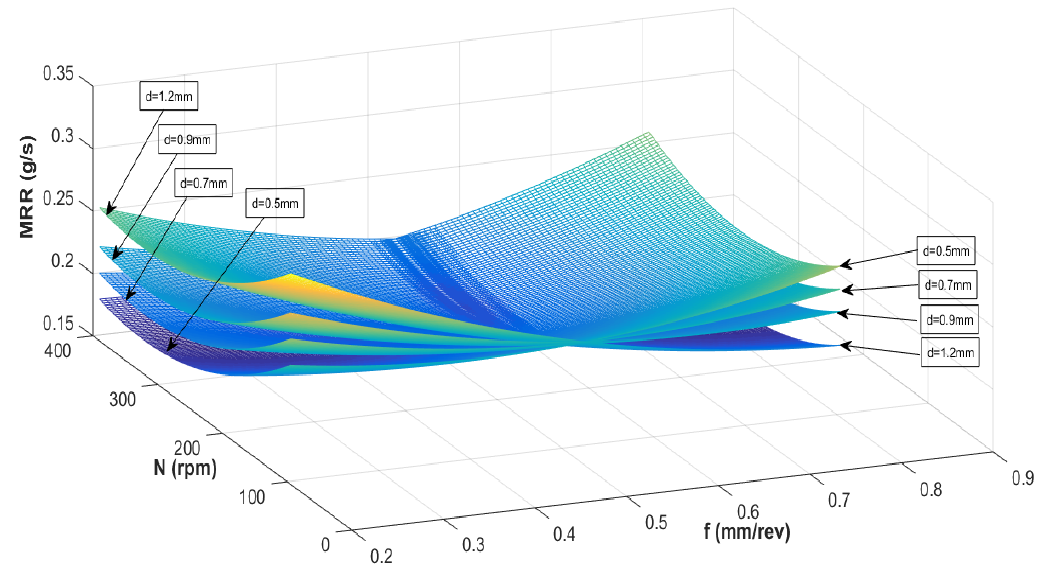
Figure 4. Interaction effect of spindle speed (N) and feed rate (f) on MRR at different depth of cuts.